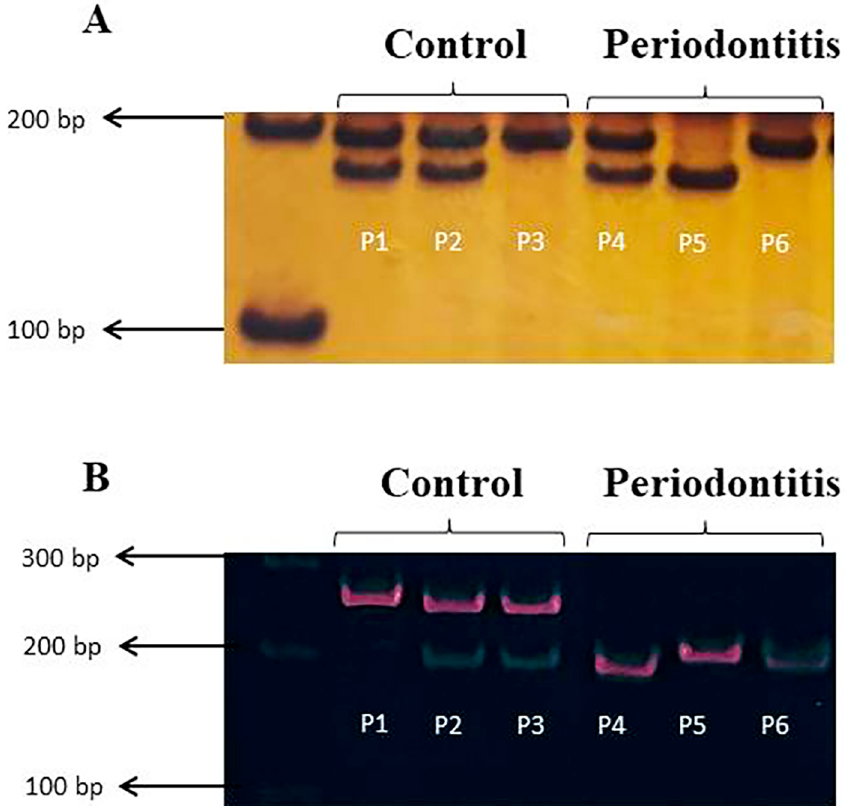
Figure 1- Representative bands of MTHFR and DNMT3B stained with silver nitrate or GelRed ® following the PCR-RFLP method for both control and periodontitis groups. (A) Amplicons for the MTHFR SNP in exon: CC=198 bp, CT=198, 175 and 23 bp (not shown), TT=175 and 23 bp (not shown); (B) Amplicons for the DNMT3B SNP in gene promoter: CC=230 bp, CT=230, 172 and 58 bp (not shown), TT=172 and 58 bp (not shown). P1-P6=patient 1–patient